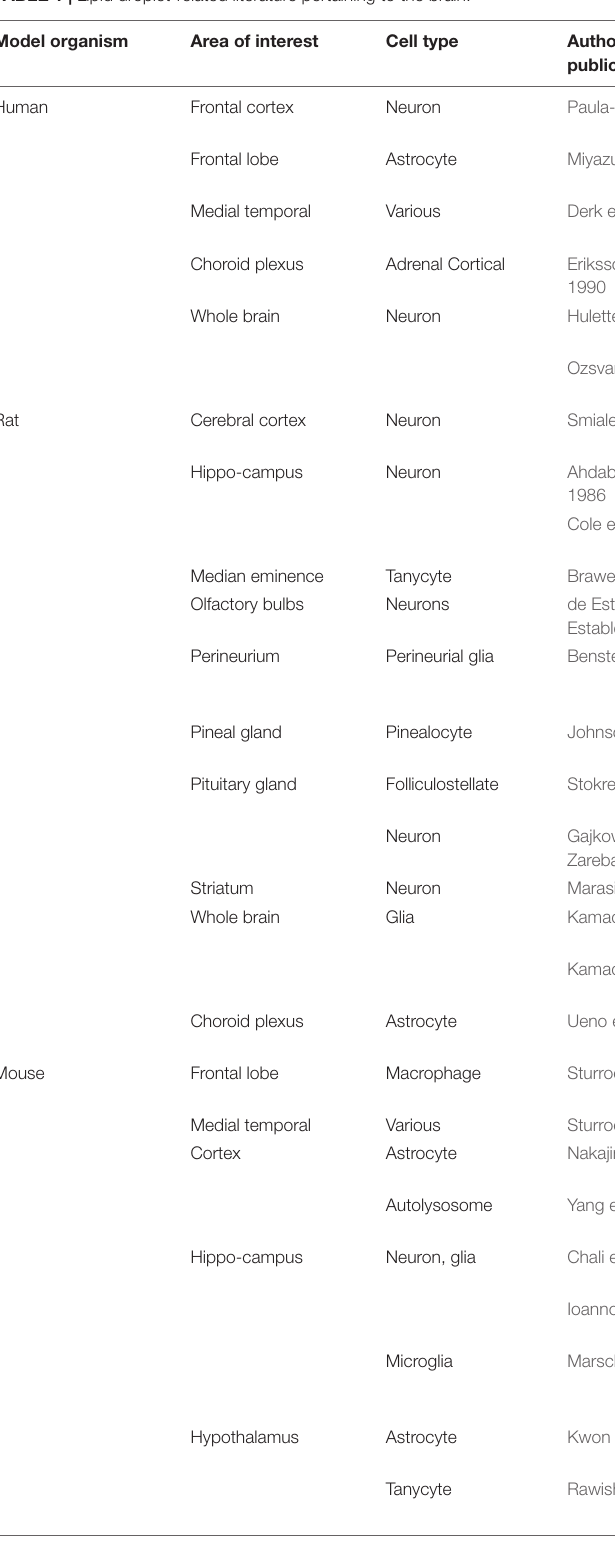
TABLE 1 | Lipid droplet-related literature pertaining to the